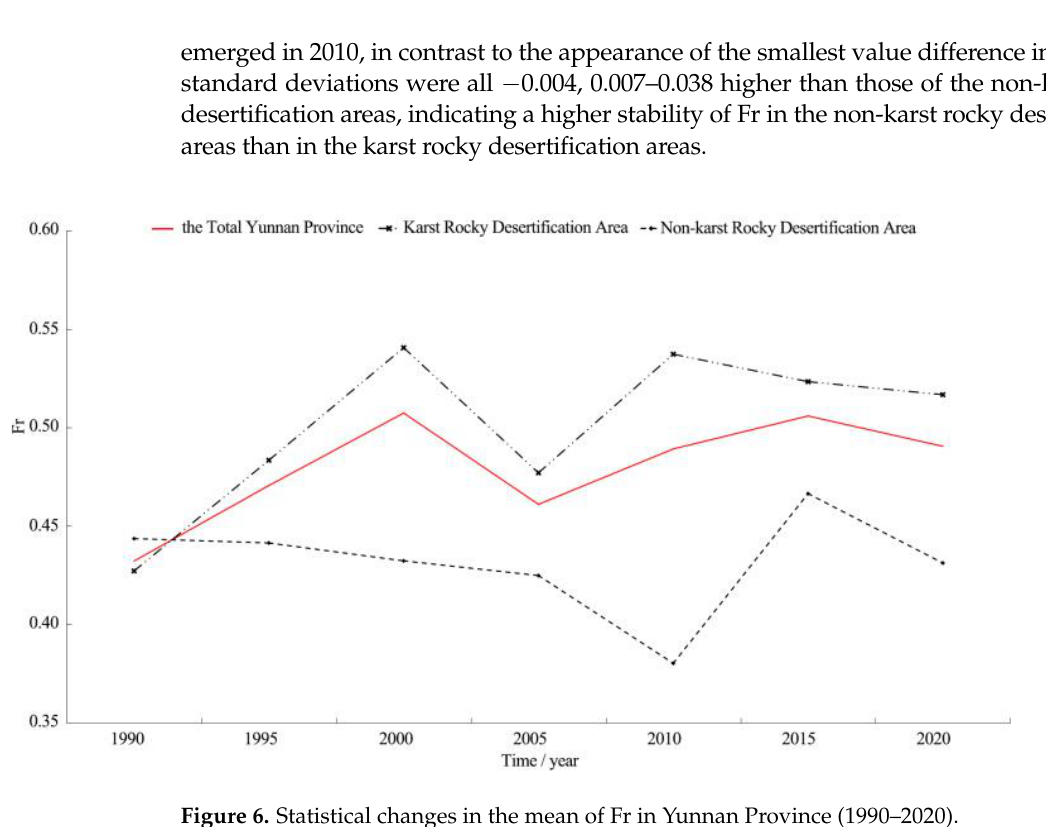
Figure 6. Statistical changes in the mean of Fr in Yunnan Province (1990 – 2020).